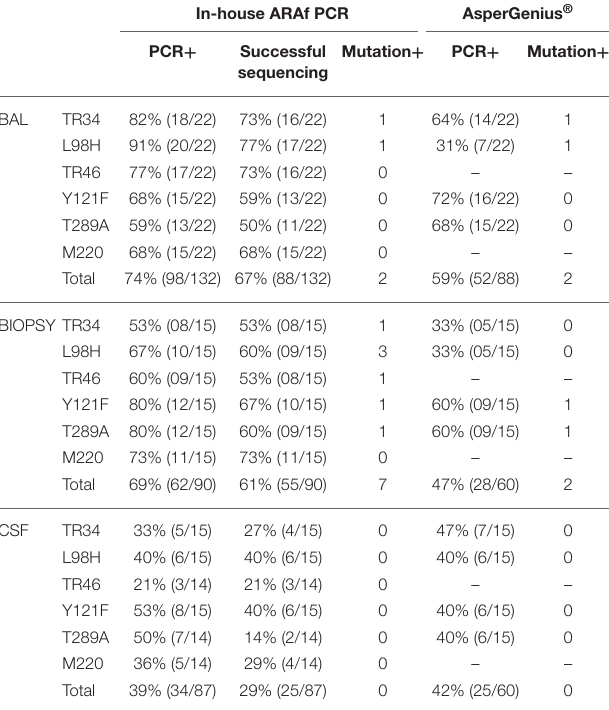
TABLE 2 | Summary of the comparison of positive diagnostic results of ARAf PCR assays and the AsperGenius ® system concerning the detection of A. fumigatus DNA and Cyp51A mutations directly from clinical